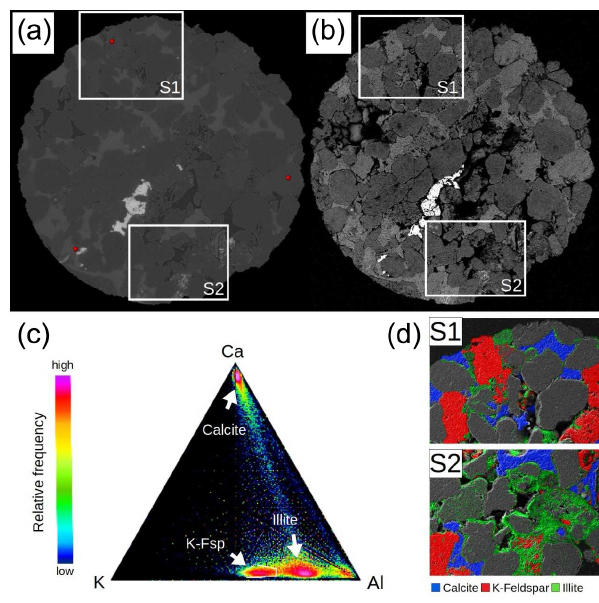
Figure 5. (a) µXCT and corresponding (b) BSE image of the pol- ished section including the close-up regions S1 and S2 that were used for EDX mapping to analyse the distribution of illites. (c) Ternary plot of Ca, K and Al content of each pixel in the mappings. Calcite, illite and K-feldspar plot in three distinct regions. By se- lecting these areas, a phase map overlay was created that visualizes the location of these phases in SE images. (d) Region S1 and S2 with phase map overlays. Illite is predominantly found in the vicin- ity of altered feldspars, as coating along grain boundaries and as authigenic pore